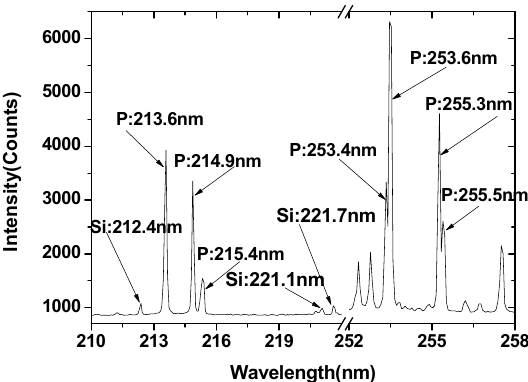
Figure 2. LIBS spectrum of compound fertilizer sample in the ranges of 210–222 and 252–258 nm (n =